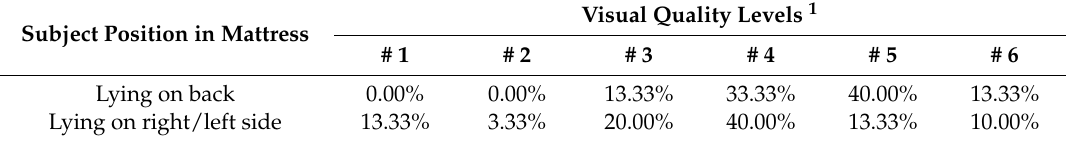
Table 3. Visually identified non-contact ECG quality for the collection of every best segment per measurement.